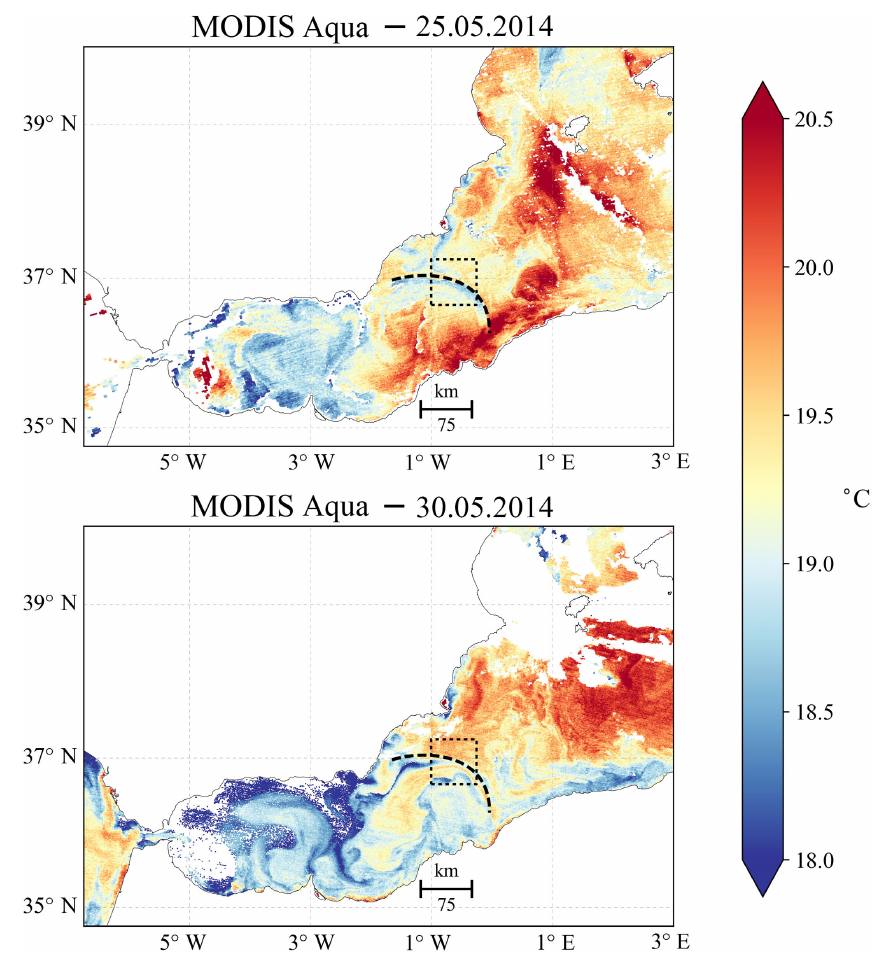
Figure 2. Sea surface temperature in the western Mediterranean Sea from MODIS sensor onboard Aqua satellite corresponding to 25 and 30 May 2014. The dashed black line indicates the approximate position of the front based on the temperature gradient for the period 25–30 May. Level-2, 11µm, night-time images were selected. Only pixels with a quality flag equal to 1 (good data) were conserved and represented on the map. The same front position is used in the subsequent